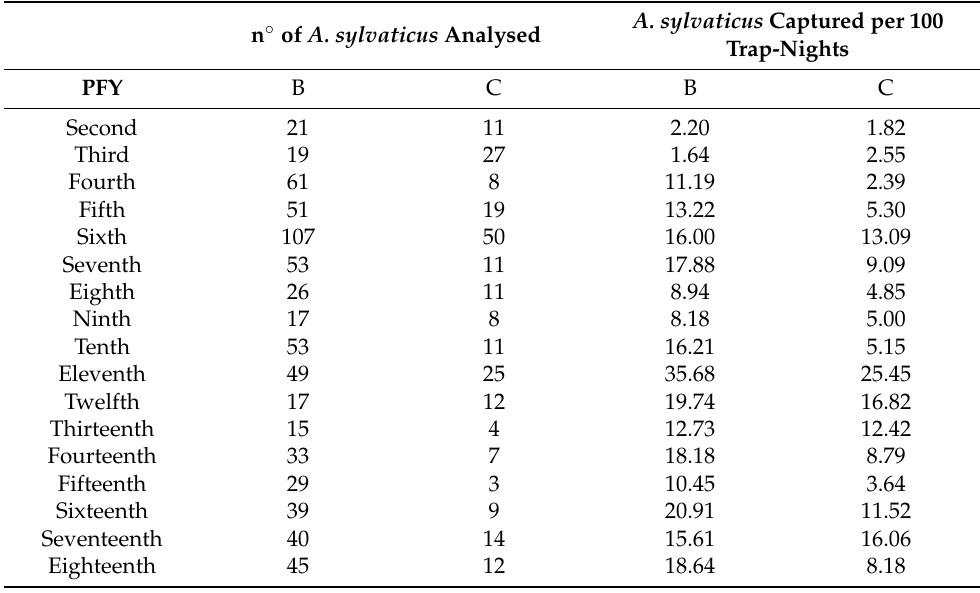
Table 1. Number of wood mice analysed and number of individuals captured per 100 trap-nights by post-fire year (PFY) in the burned (B) and control (C) areas. A. sylvaticus Captured per n ◦ of A. sylvaticus Analysed